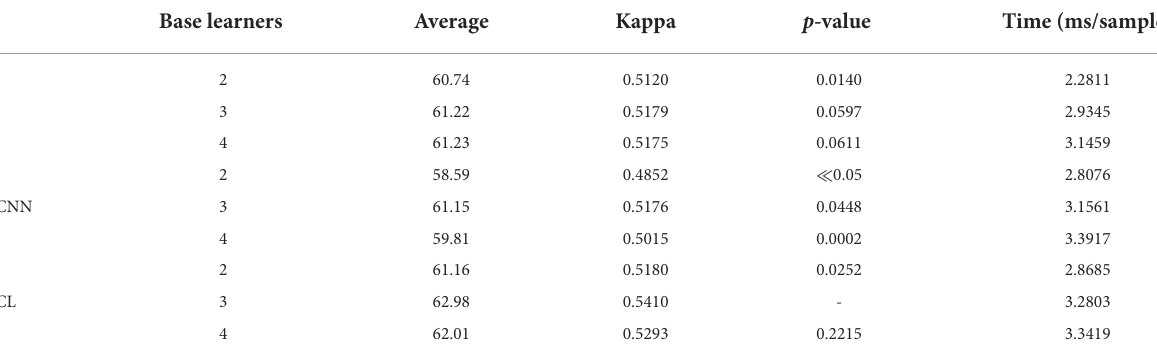
TABLE 6 Performance comparison of different approaches on six MI classes Tohoku University MI-BCI dataset with different number of base